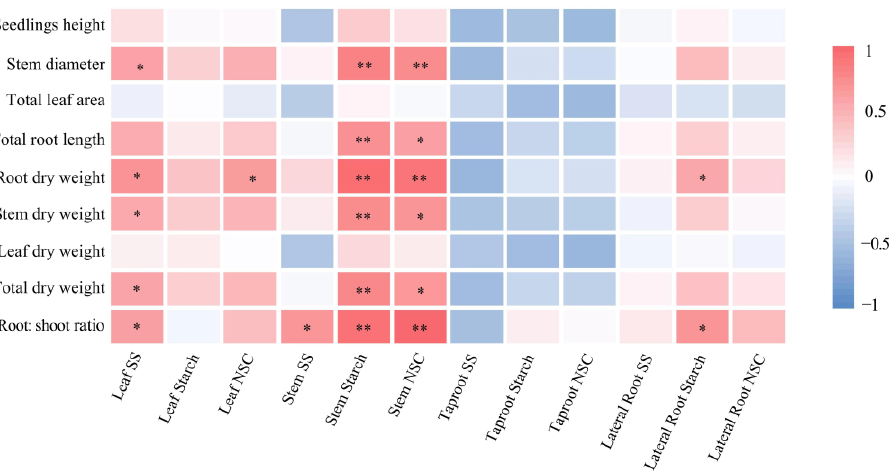
Figure 7. Correlation coefficient matrix of Mongolian oak seedlings growth, biomass, and NSC content in each organ. * p < 0.05; ** p < 0.01.